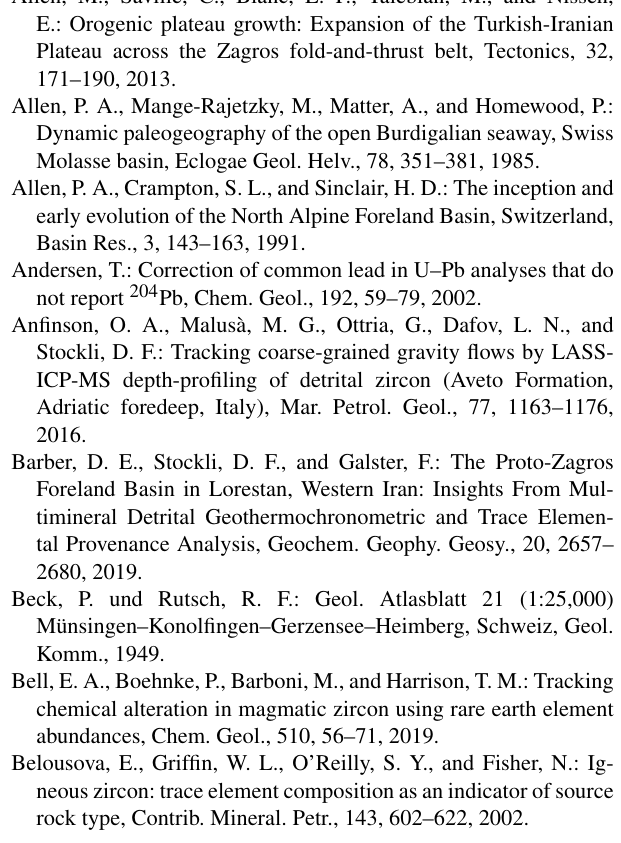
Supplement. Table S1: all depth-profiled detrital zircon U–Pb data. Table S2: all geochemistry data from LASS